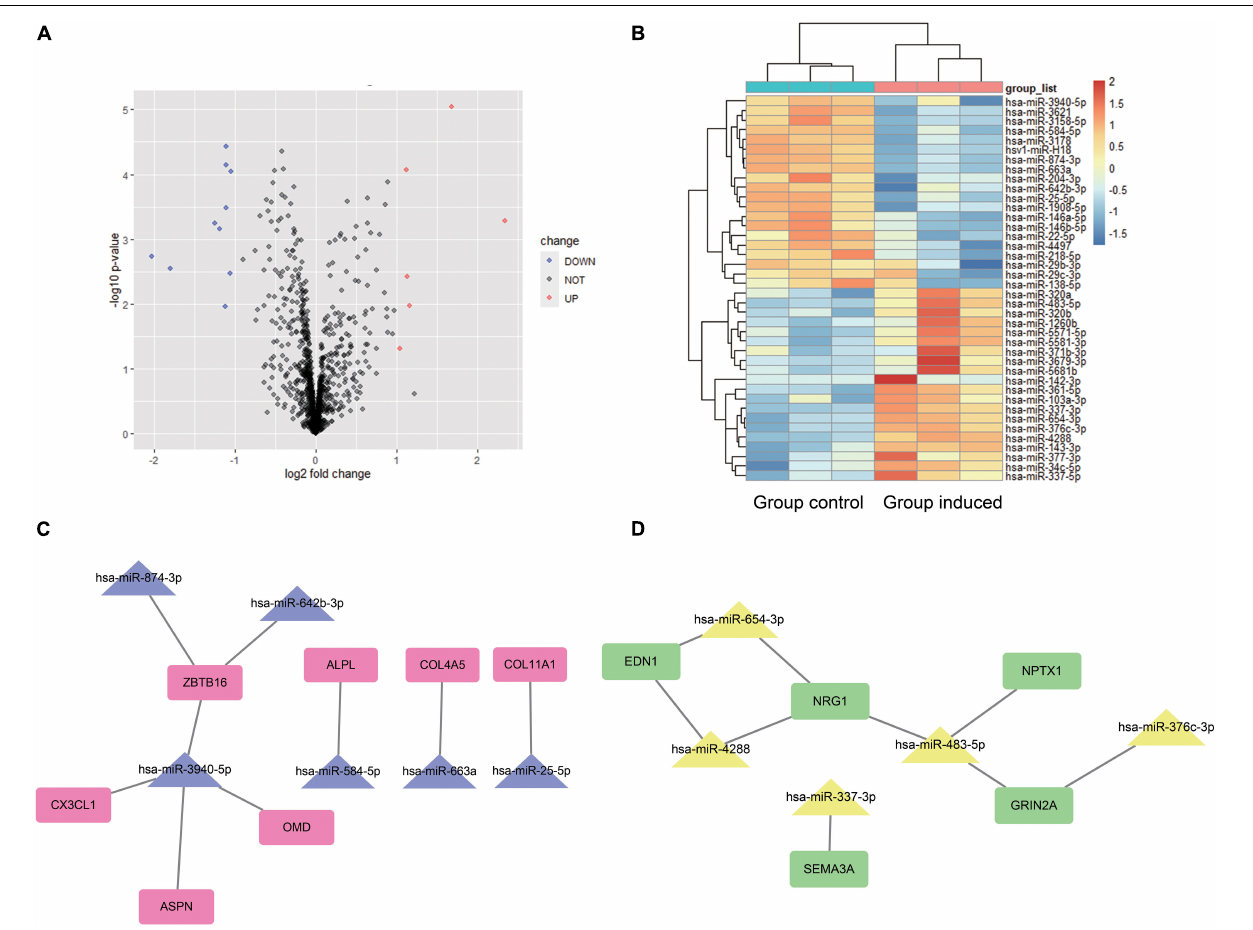
FIGURE 4 | Differentially expressed miRNA analysis and miRNA-mRNA potential interaction network construction. For the miRNA-seq dataset GSE159508, limma package was used to analyze the DEMs between the Group induced and the Group Control. A volcano plot (A) and heat map (B) shows the 16 DEMs. Red color indicates six up-regulated miRNA, and blue indicates 10 down-regulated miRNA. The predicted target genes of DEMs is calculated by miRWalk website. After the predicted target genes of DEMs and the obtained hub genes were intersected, a negatively regulated PPI of miRNA-mRNA network was obtained (C,D) . We obtained five up-regulated (miR-337-3p, miR-376c-3p, miR-4288, miR-483-5p, and miR-654-3p) and 6 down-regulated (miR-25-5p, miR-3940-5p, miR-584-5p, miR-642b-3p, miR-663a, and miR-874-3p) DEMs that potentially interacted to hub genes. Group Control: PDLSCs treated with control medium. Group induced: PDLSCs treated with osteogenic